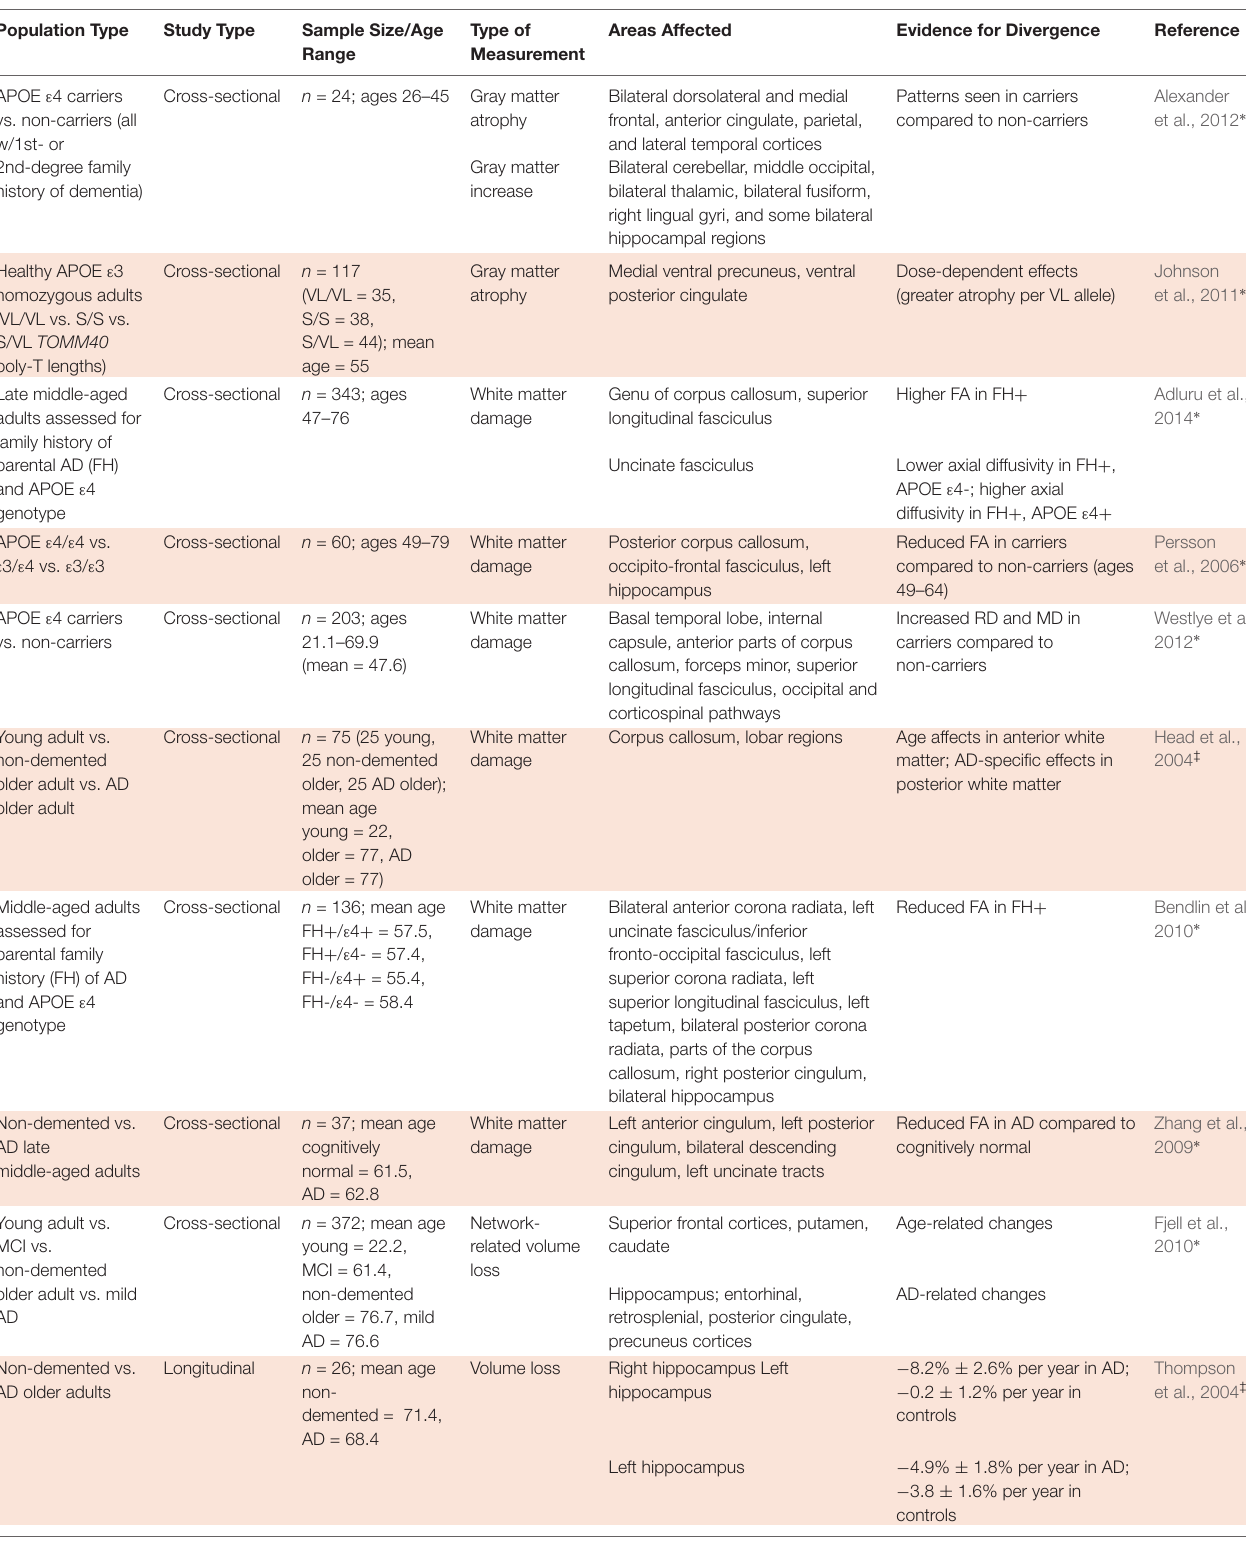
TABLE 3 | Divergence of healthy and pathological aging in structural neuroimaging